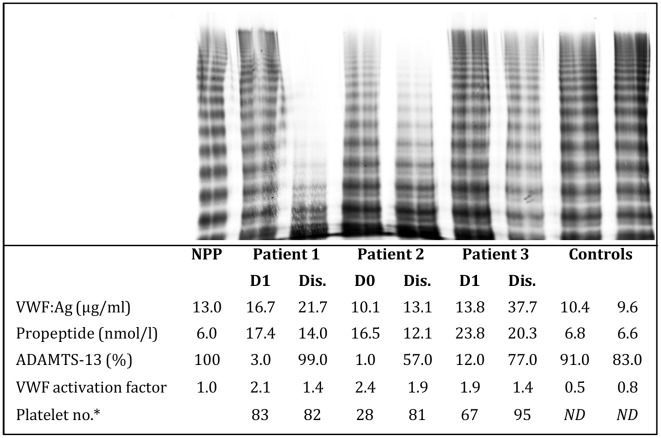
VWF multimer pattern in Indonesian children with dengue.Plasma VWF multimer distribution was analysed by agarose gel electrophoresis, followed by in-gel immunostaining. Electrophoresis was performed from the top to the bottom. Plasma at discharge (Dis) from 3 children with severe dengue (patient 1–3) demonstrated a reduction in large and intermediate VWF multimers compared to plasma at enrollment (D0) or day 1 (D1), consistent with an acquired von Willebrand disease. No ultralarge VWF multimers were seen. NPP depicts normal pool plasma. VWF:Ag, VWF antigen. * The last available platelet count before discharge is given.